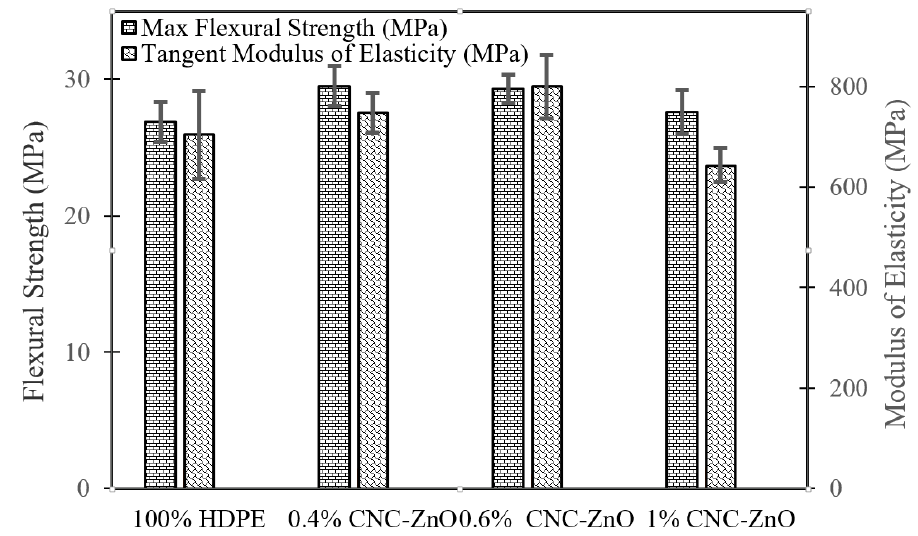
Figure 5. Mechanical Properties of HDPE and CNC-ZnO Formulations.